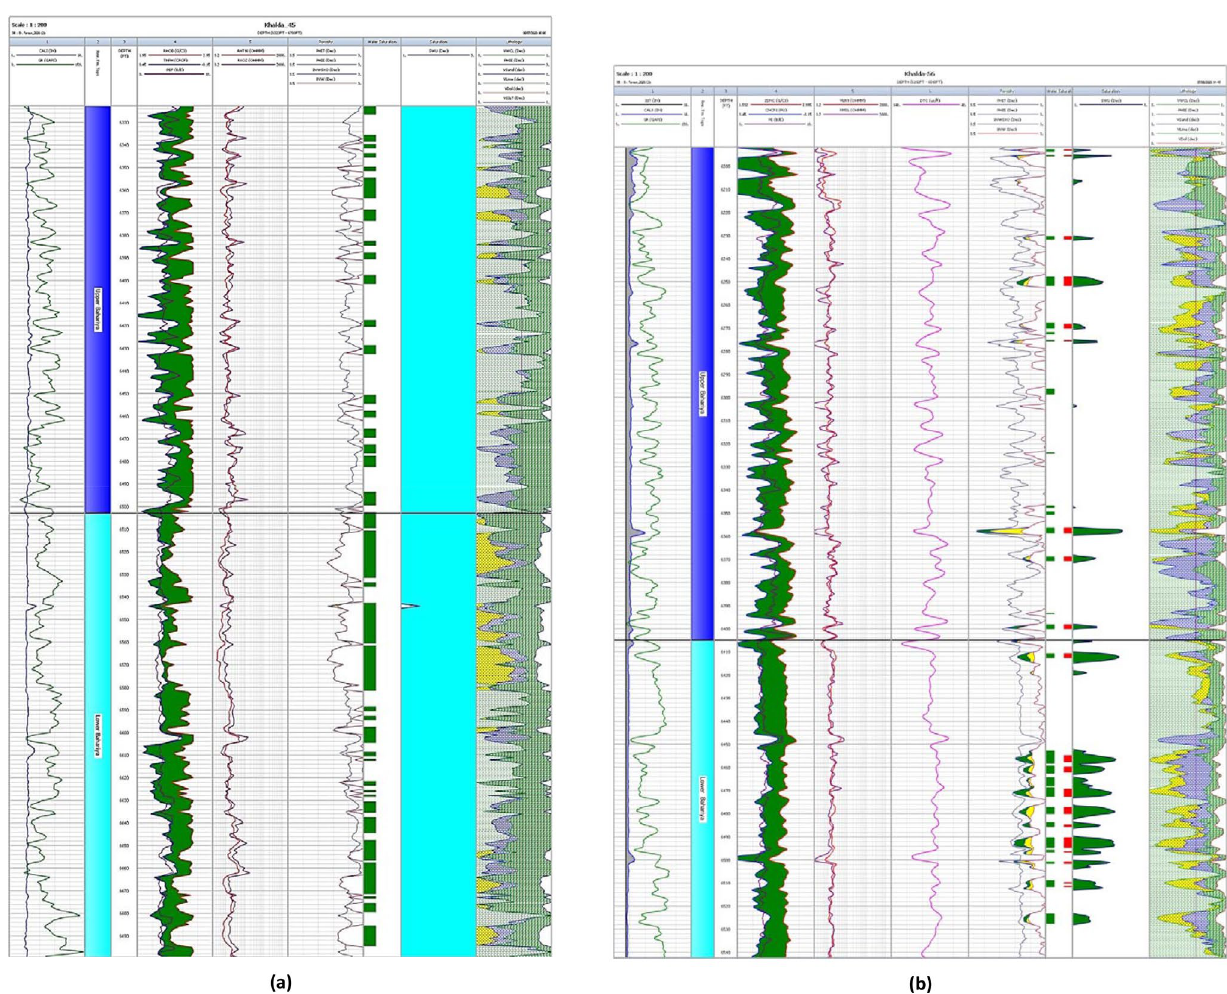
Fig. 19 Litho-saturation cross-plots of the Bahariya Formation, showing the lithology, total and effective, shale volume, porosity, water satura- tion and net pay zones for a Kh_45 well, and Kh_56